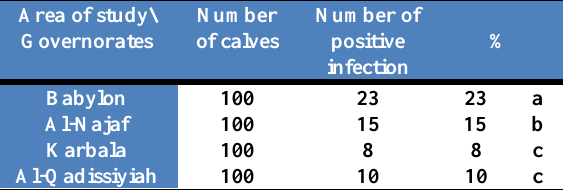
Table, 7: Percentages of rotraviral infection of calves in areas of